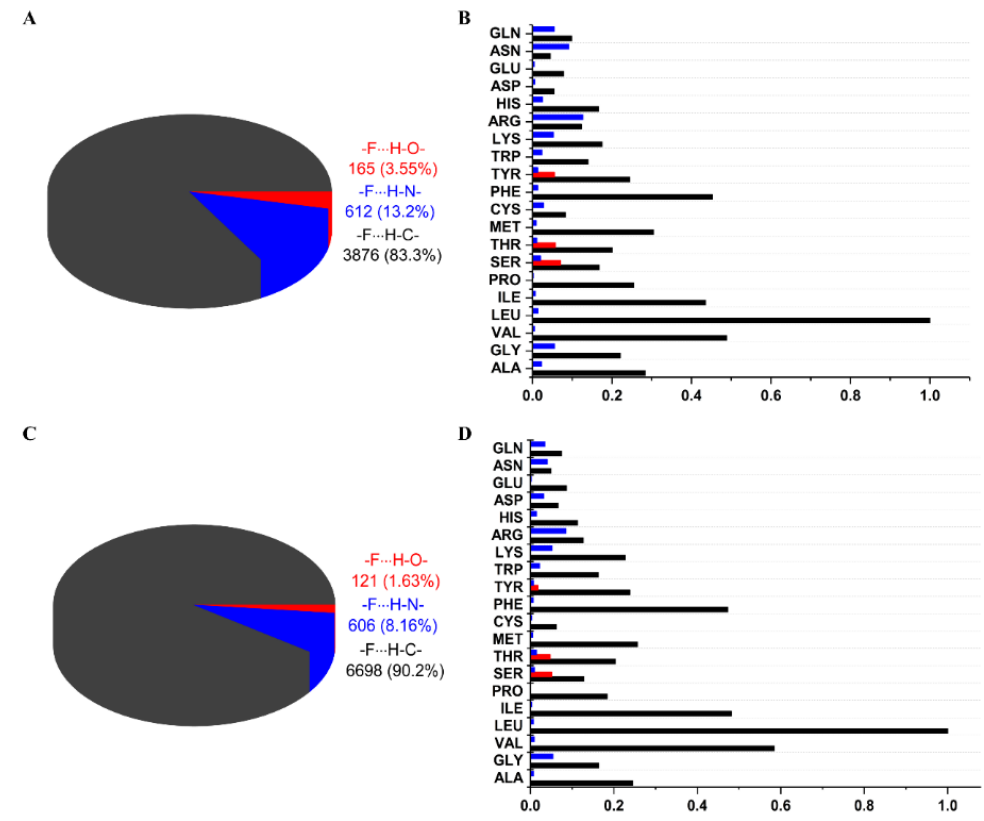
Figure 3. Number of hydrogen bonds found in the PDB repository to meet the boundaries for geometric parameters: ( A ) between F al and OH, NH, and CH donors; ( B ) normalized division into interacting amino acids; ( C ) between F ar and OH, NH, and CH donors; and ( D ) normalized division into interacting amino acids.